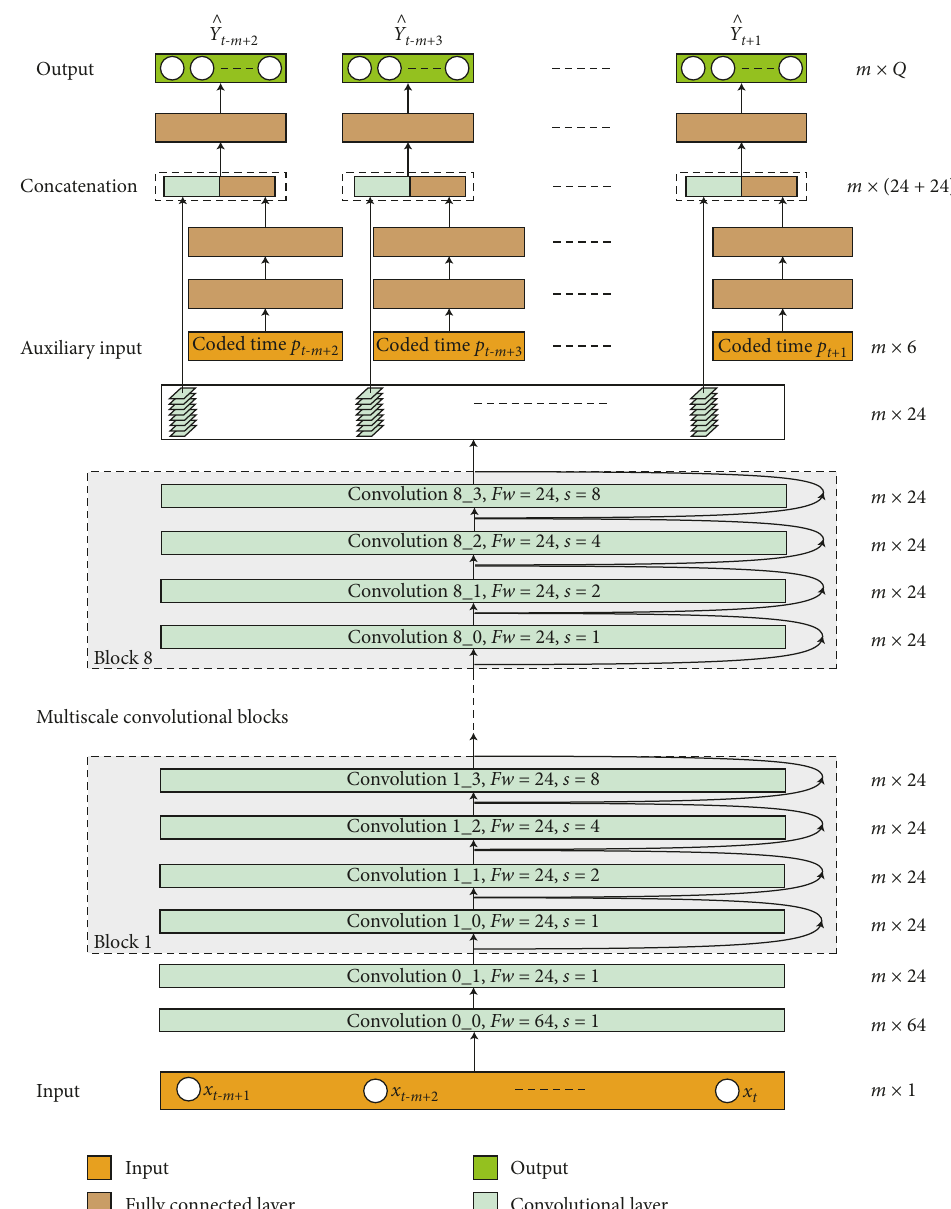
Figure 6: Two subnetworks MS-CNN and fully connected networks build up the baseline of proposed model for multiscale and periodical coding features